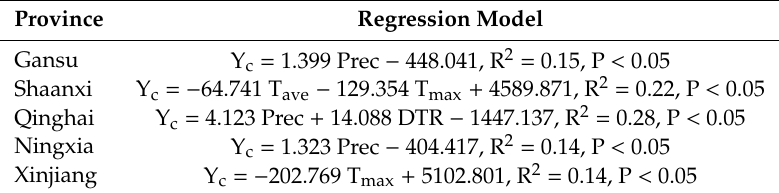
Table 5. Regression models established in di ff erent provinces of northwest